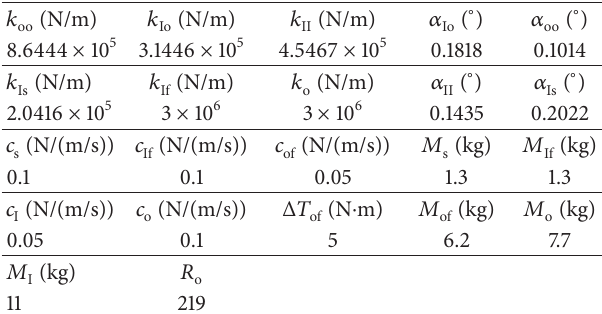
Table 2: Characteristic parameters of the example EIMG